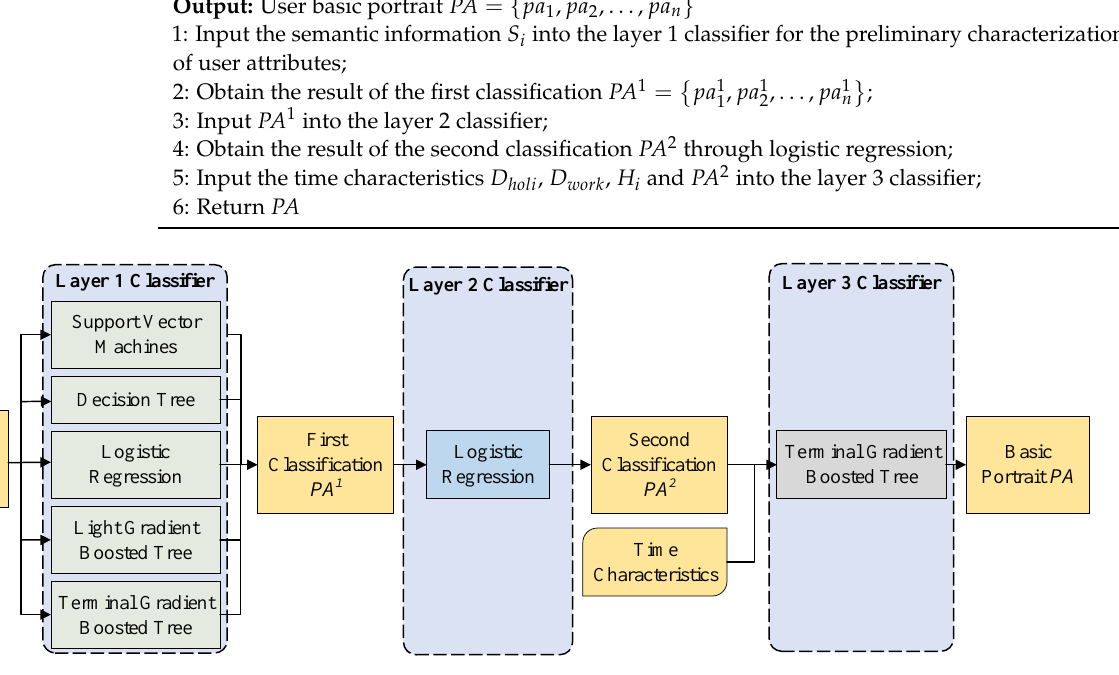
Figure 2. The three-layer classifier.